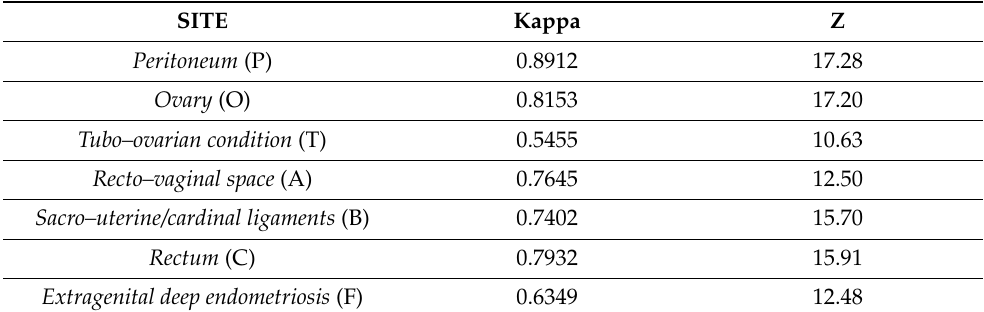
“SITE” represents different pelvic regions considered separately by each reader applying the score. “K” represents degree of concordance between readers expressed through the following reading criteria: k < 0 non